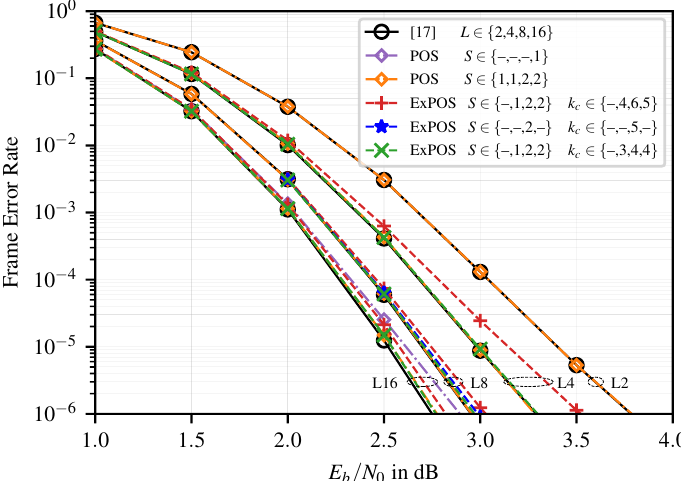
Figure 10. Error-correction performance of Polar code N = 1024, R = 1/2.